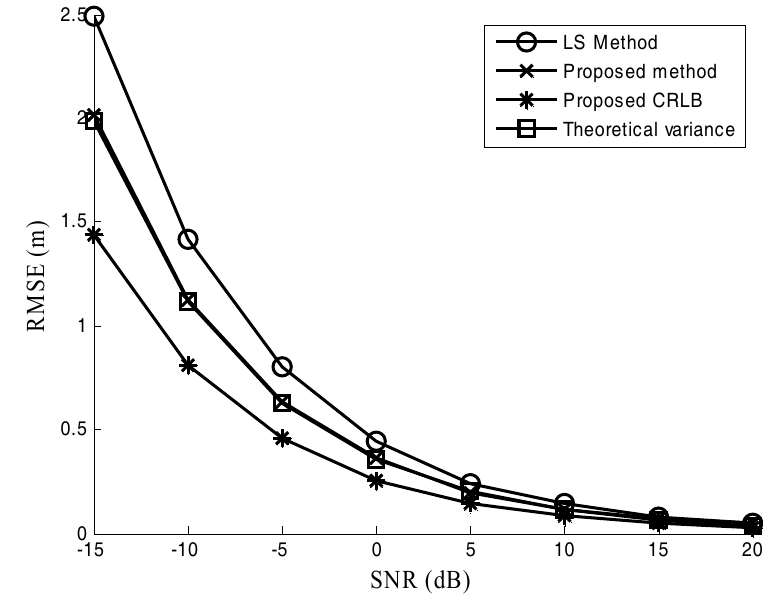
Figure 7. Positioning error under different SNR.